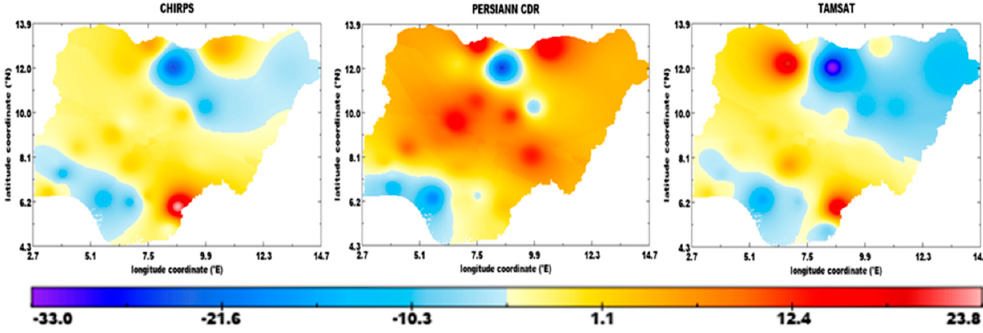
Figure 10. Percent bias (PBIAS) of annual rainfall (mm / year)over Nigeria.